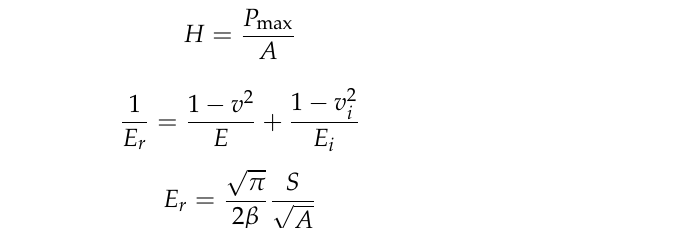
Figure 5. Load-contact stiffness variation curve.